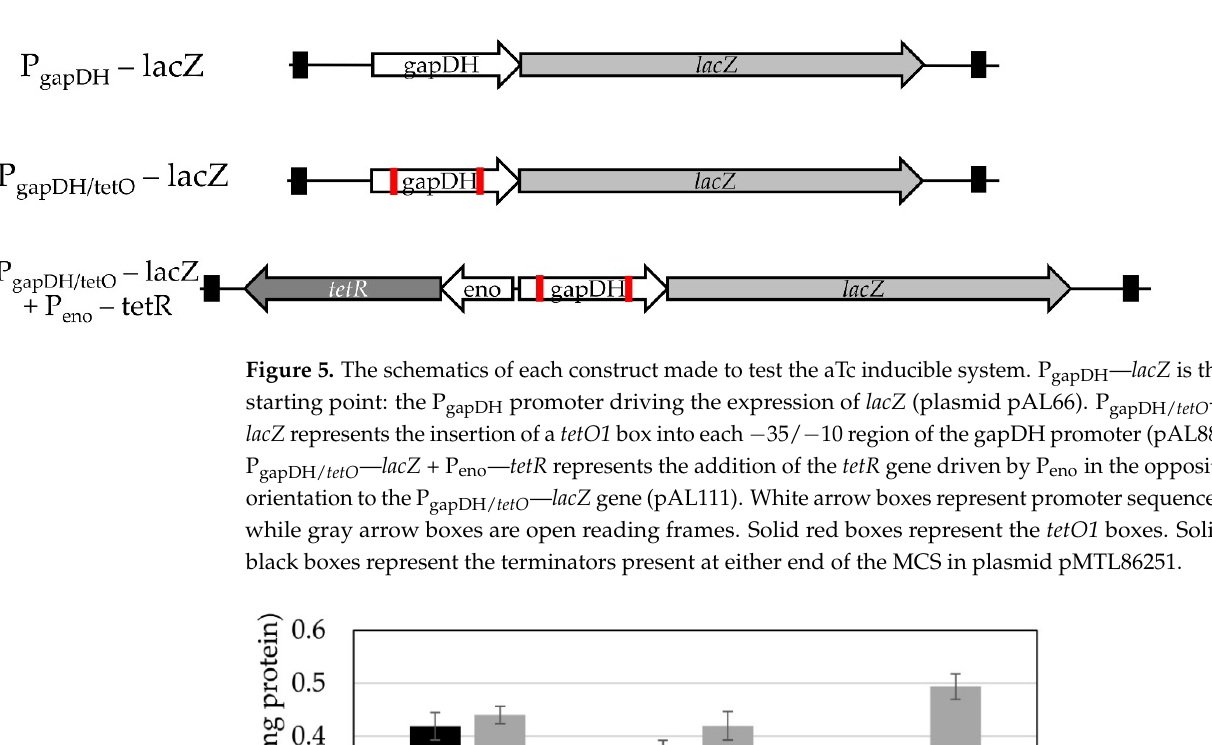
8 of 13 or at 14.5 h ( B ). Each point represents the average of three replicates; error bars represent a standard deviation. Curves represent fittings to a logistic function [13]. We chose the constitutive promoter associated with the highest β -gal expression in H. modesticaldum —gapDH—as the starting point for an aTc-inducible system. The gapDH promoter has two annotated − 35/ − 10 regions [16]; therefore, the tetO sequence tetO1 [22] was added to both sites (Figure 5). The replacement of the 15- or 17-bp spacer region be- tween the − 35 and − 10 boxes with the 18-bp tet operator resulted in only a ~7% drop in β - gal expression (Figure 6).